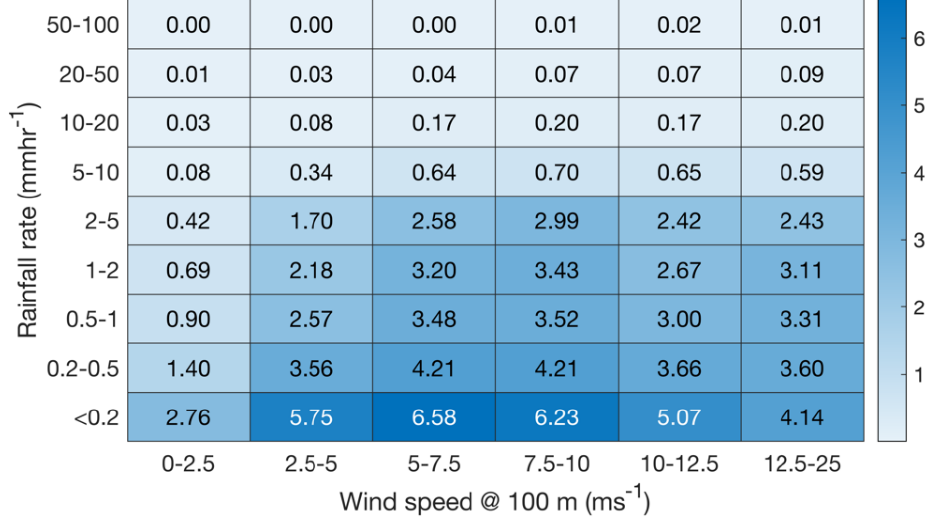
Figure 12. Heatmaps of the joint probabilities (in %, colorbar and also numeric values shown in each cell) of RR and wind speeds at coastal Norway. The probabilities are computed using once hourly wind speeds at a nominal height of 100 m from NORA3.